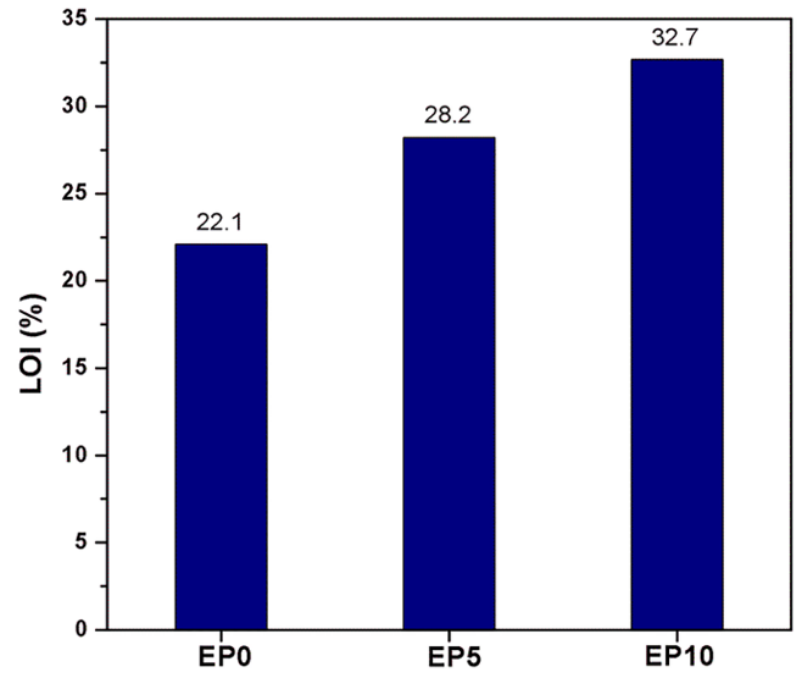
Figure 5. LOI results of EP